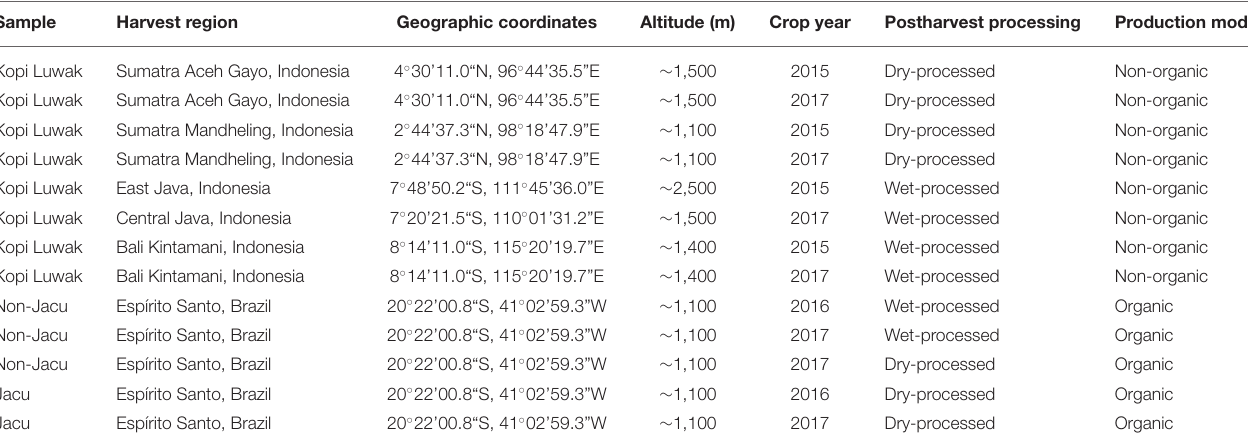
TABLE 1 | Harvest region, greographic coordinates, altitude, crop year, postharvest processing, and production mode of the green coffee samples investigated in the present study. Sample Harvest region Geographic coordinates Altitude (m) Crop